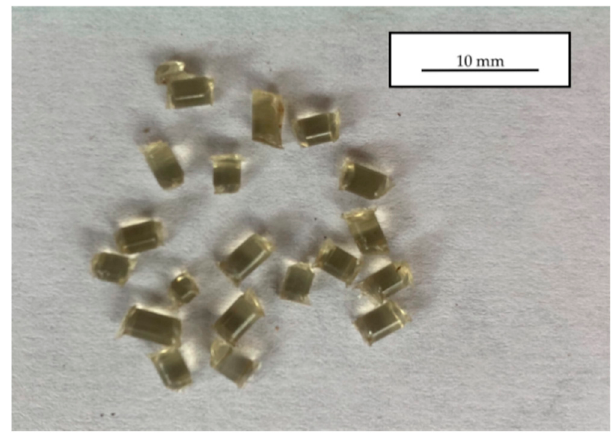
Figure 3. Optical image of the pellets after the granulator.